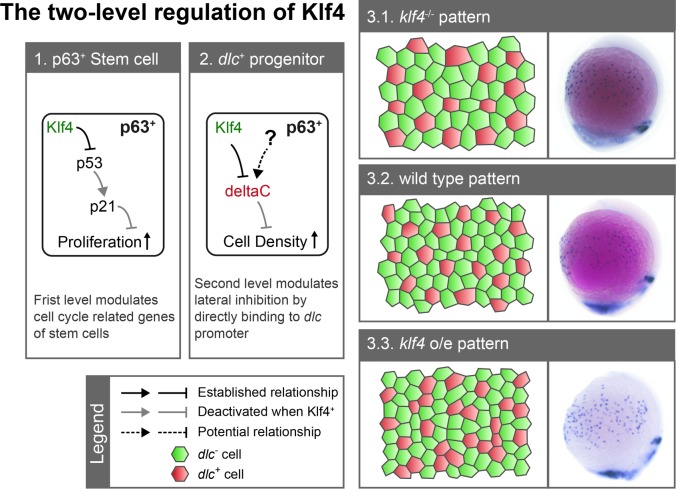
A proposed model for Klf4 functions in maintaining the dlc+ ionocyte progenitor population.Zebrafish Klf4 exerts two-level regulatory activity toward the development of ionocytes. In wild-type embryos, Klf4 represses p53 expression, preventing the induction of cdkn1a/p21, and thereby allowing proper p63+ epidermal stem cell proliferation (box 1). At a second level, Klf4 acts as a repressor, regulating Dlc-mediated lateral inhibition by binding to the dlc promoter to maintain proper dlc+ ionocyte progenitor population and patterning during the initiation of ionocyte progenitor differentiation (box 2). The output patterns are illustrated in 2D cell schematics, and representative images of dlc mRNA in situ hybridization from klf4 morphants, wild-type and klf4-overexpressing embryos at bud stage are shown in box 3. Under klf4 deficiency, p53 expression is no longer repressed and cdkn1a/p21 is activated, which results in reduced proliferation of p63+ epidermal stem cell and larger/fewer dlc+ progenitors after selection by lateral inhibition (box 3.1). When klf4 is overexpressed (box 3.3), more stem cells are selected as ionocyte progenitors and dlc+ progenitor clusters develop.